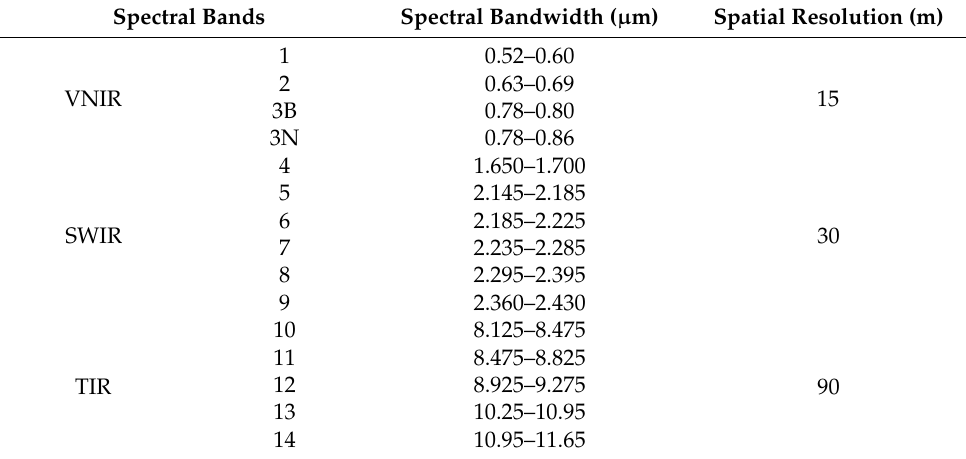
Table 1. Characteristics of ASTER satellite imagery